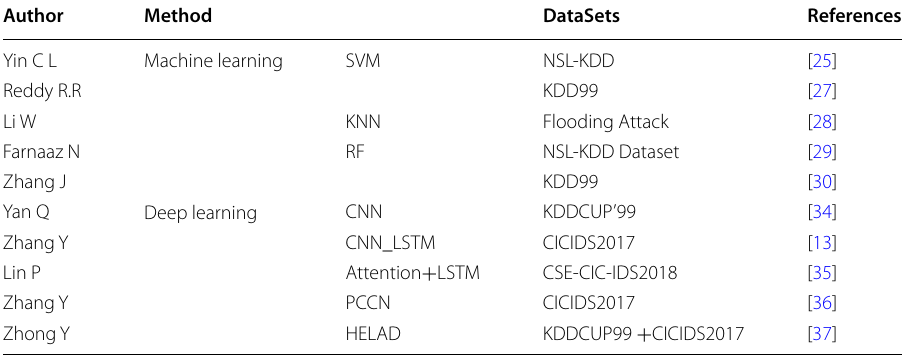
Table 1 A brief summary of intrusion detection methods